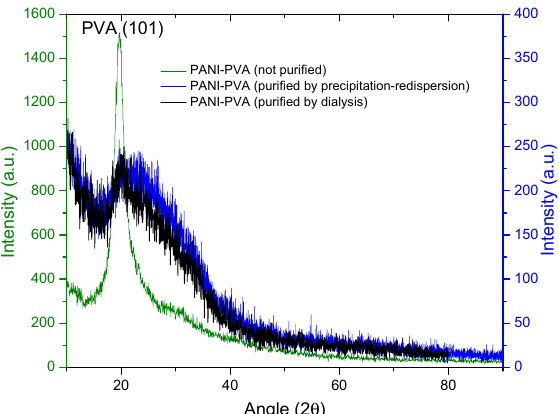
Figure 15. XRD diffractogram comparison for unpurified and purified PVA–PANI by precipitation–redispersion and dialysis.